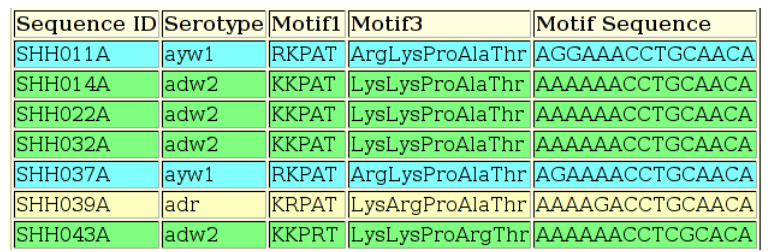
Figure 7. Output of the HBV Serotyping Tool, showing the sequence ID, the serotype, the amino acid motif for all five positions using both the one-letter amino acid abbreviations (“Motif1”) and the three-letter abbreviations (“Motif3”) and the nucleotides present at all five amino acid positions. All five amino acids are not required in order to deduce some serotypes, but all five positions are included for all samples for